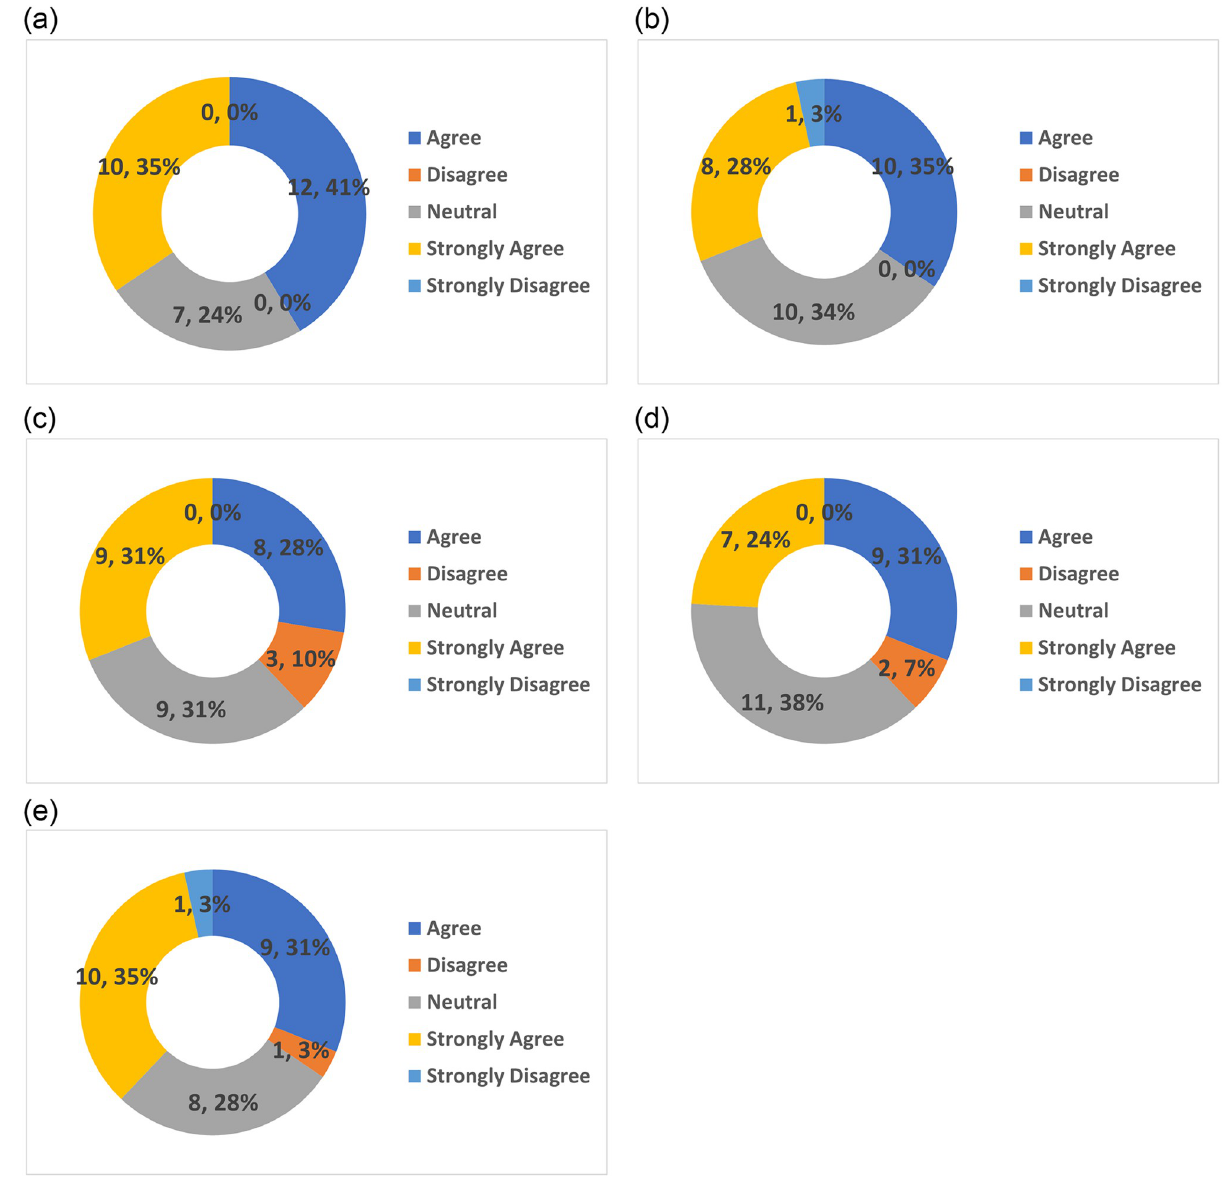
Fig 9. Depression level statistics according to participants interactions. ( a ) Participants’ Response to Question 1. ( b ) Participants’ Response to Question 2. ( c ) Participants’ Response to Question 3. ( d ) Participants’ Response to Question 4. ( e ) Participants’ Response to Question